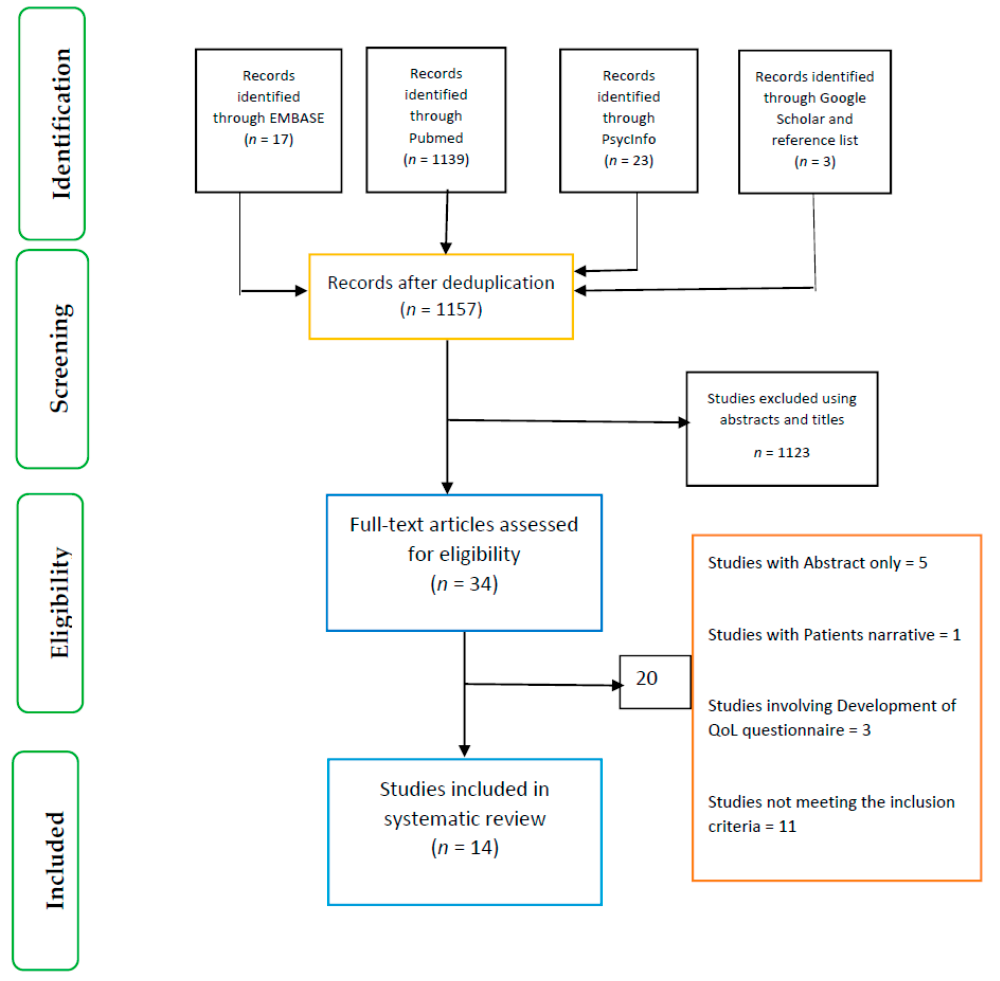
Figure 1. Prisma flow chart.